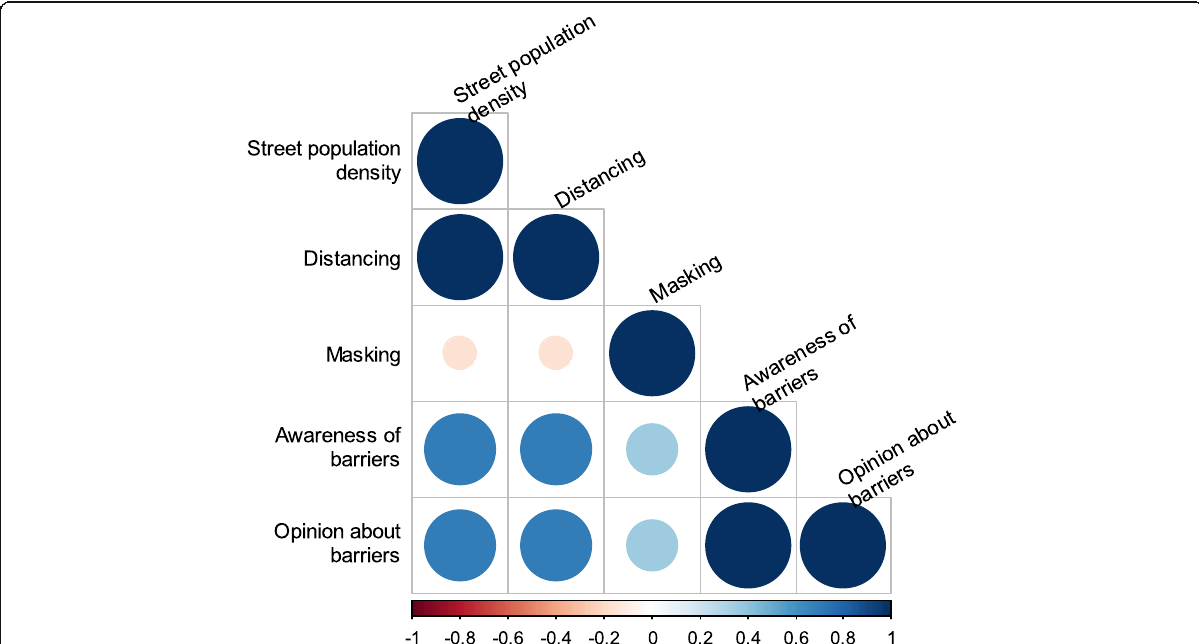
Fig. 2 Correlation matrix between the main variables of the questionnaire. The colored scale shows the values of Spearman correlation coefficients. Blue points correspond to positive correlations and pink ones to negative correlations. The size of each point is proportional to the strength of